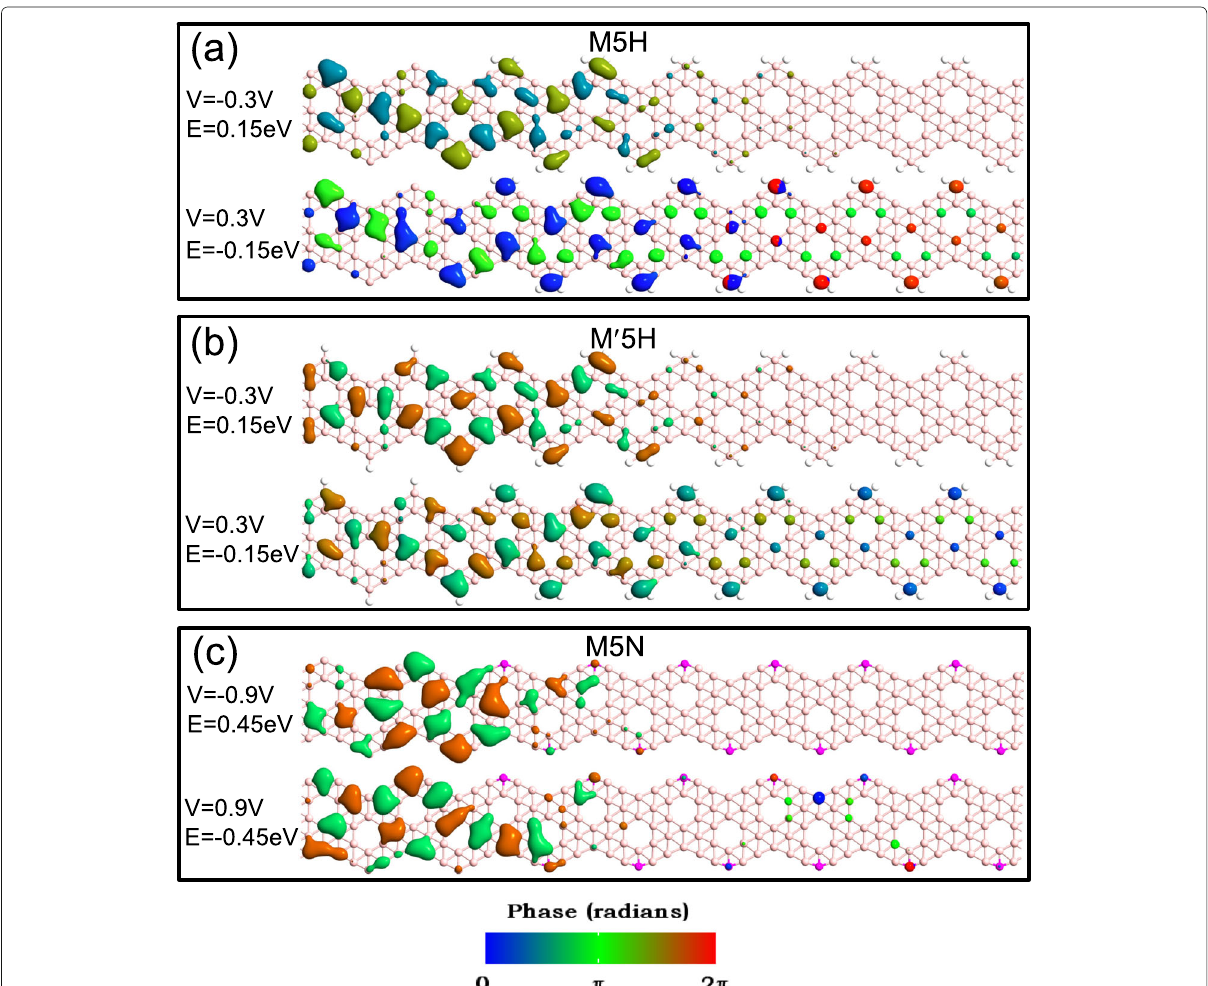
Fig. 6 The transmission eigenstates for heterojunction a M5H at bias − 0.3 V with E =0.15 eV (upper) and at bias 0.3 V with E = − 0.15 eV (lower), b M (cid:2) 5H at − 0.3 V with E =0.15 V and at 0.3 V with E = − 0.15 eV, and c M5N at bias= − 0.9 V with E =0.45 eV and at 0.9 V with E = − 0.45 eV, respectively. The isovalues are fixed at 0.2 Å − 3 eV − 1 for all